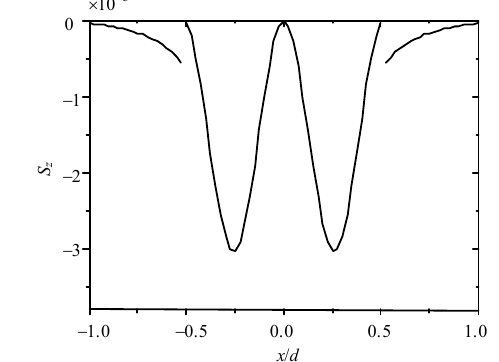
Fig. 10 Energy flux at m =